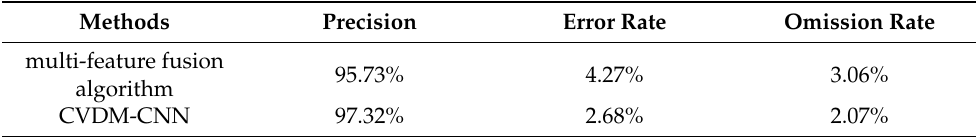
Table 4. Detection performance under complex driving environment.